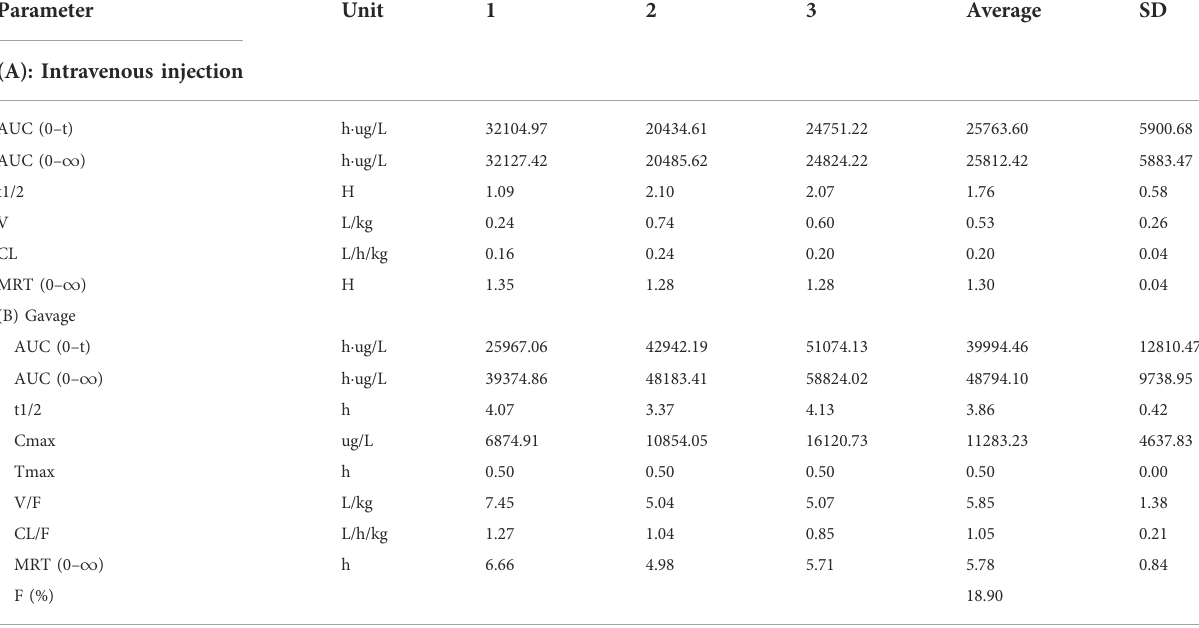
TABLE 4 Main pharmacokinetic parameters of NAY after intravenous injection and gavage in rats ( n = 3). Parameter Unit 1 2 3 Average